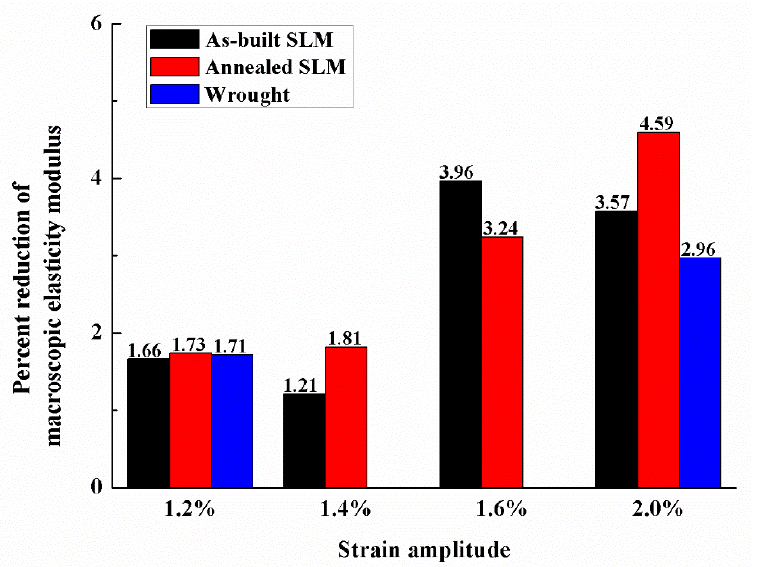
Figure 10. Variation (change between first cycle to the half-life) of the macroscopic elasticity modulus for the LCF Ti – 6Al – 4V specimens.